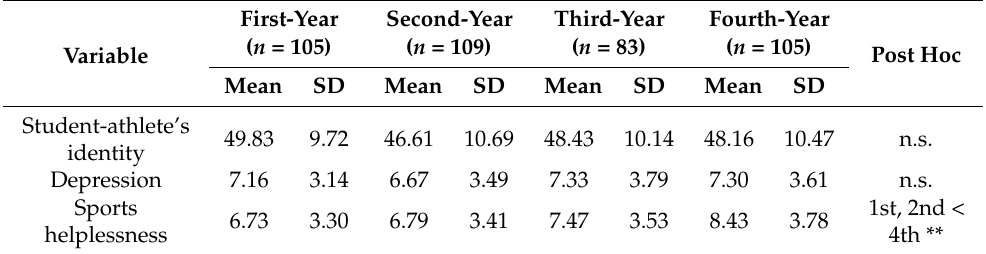
Table 1. Means (SD) and post hoc analysis for subscales between college